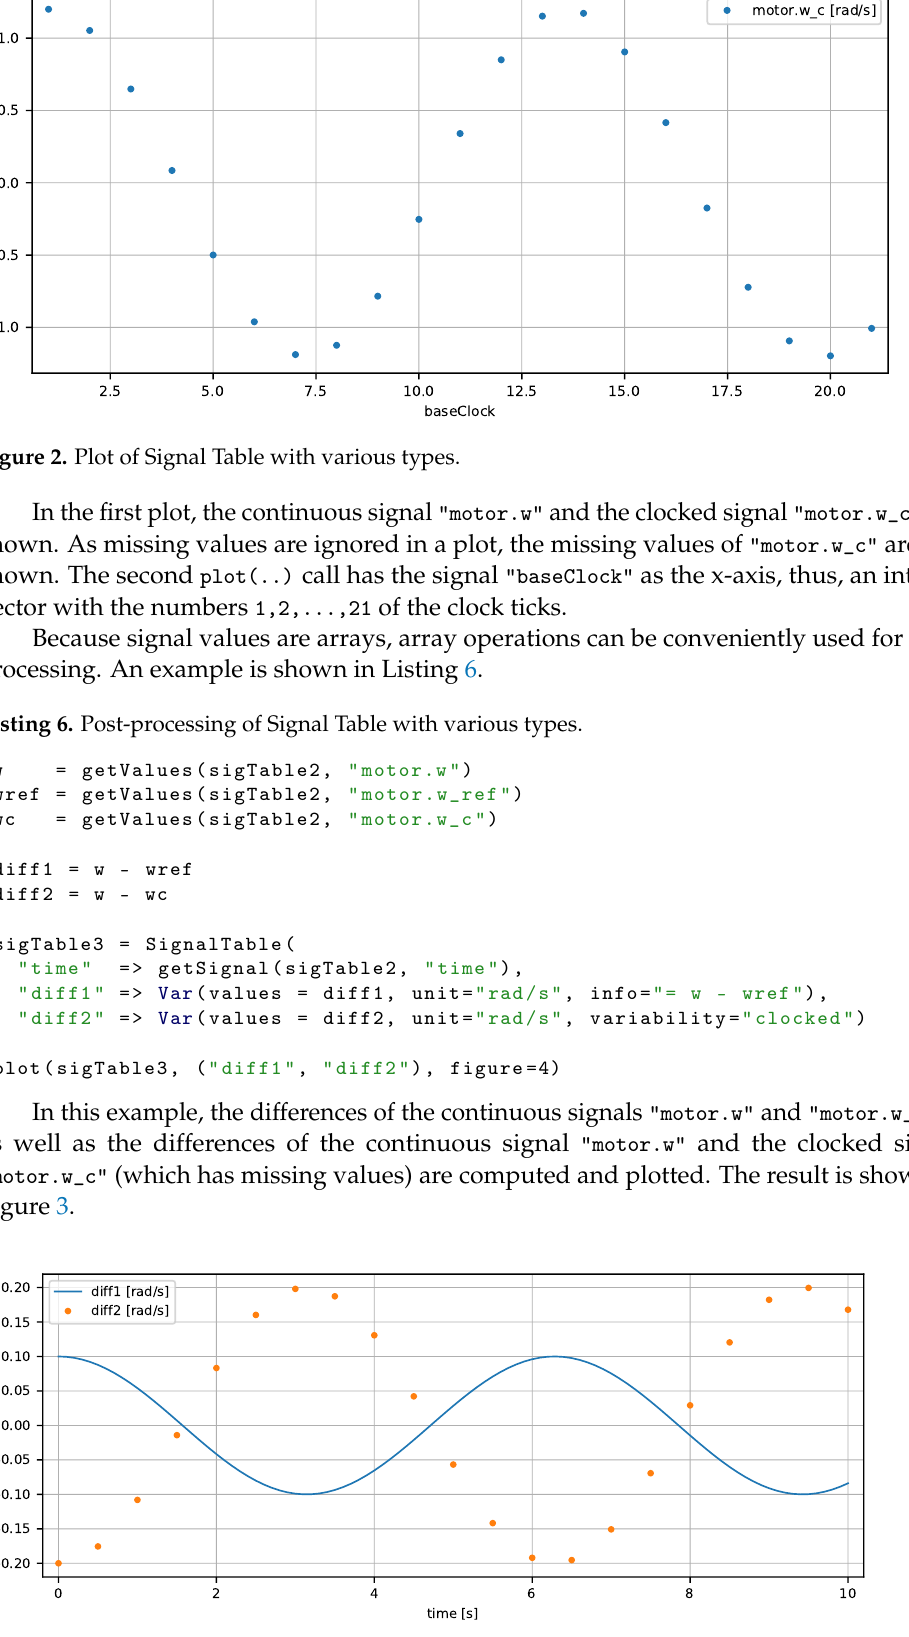
Figure 3. Plot of post-processed signals of Signal Table with various